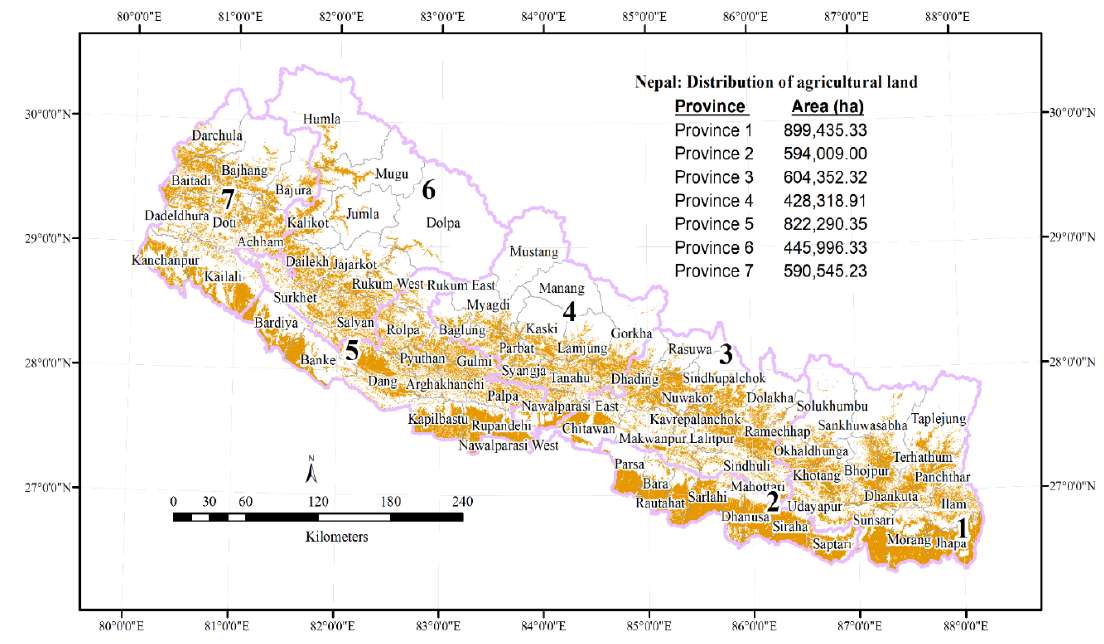
Figure 19. Distributions of agricultural land in seven provinces. Figure 20. Distributions of agricultural land in seven